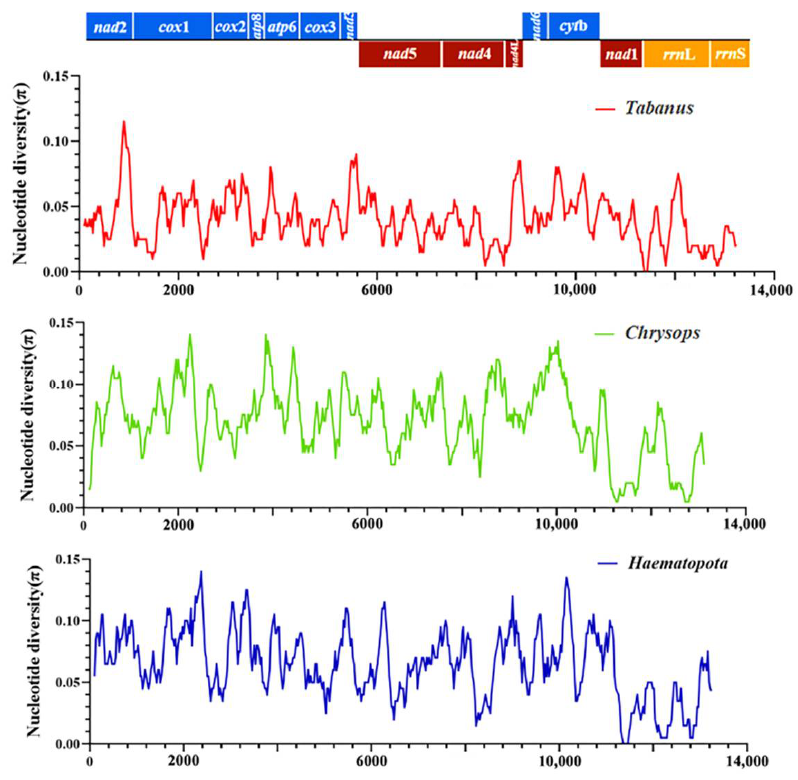
Figure 7. Nucleotide diversity (π) among the obtained mitogenomes in this study. The red lines indicate π values based on the evaluation of sequences from Tabanus genu, including Tabanus chrysurus and Tabanus pleskei . Green lines indicate π values based on the evaluation of sequences from the genus Chrysops , including Chrysops dissectus and Chrysops vanderwulpi . Blue lines indicate π values based on the evaluation of sequences from Haematopota genus, including Haematopota turkestanica and Haematopota vexativa . Values were calculated from a 200–bp sliding window analysis of 25 bp steps and plotted on the y -axis, and the length of the sequence was plotted on the x -axis.